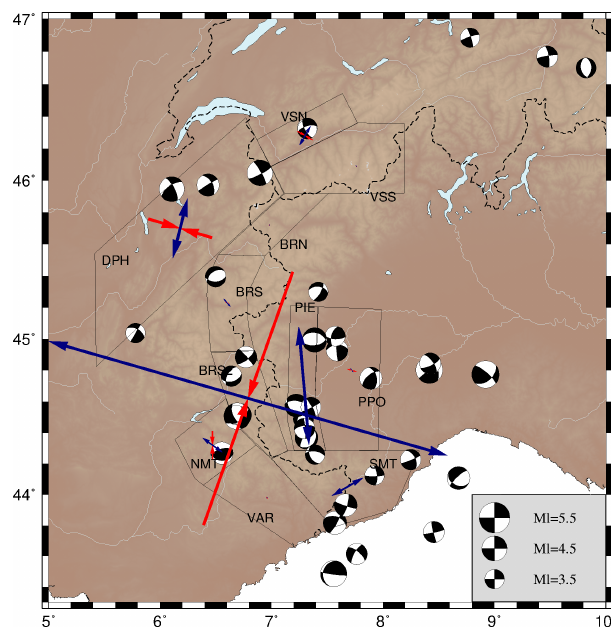
Figure 4. Seismic strain rates computed according to Kostrov’s (1974) method in each of the 11 subareas, based on 25 years of seismicity records from Potin (2016). Blue and red arrows respectively show the extensive and compressive components of the strain rate projected at the surface ( ε ∗ cos (δ) ), where ε is the given eigenvalue and δ is the dip (see values in Table 1). Black arrows represent the scale of the strain rate. Focal mechanisms with M l ≥ 3.5 are represented in the background since strain rates mostly depend on higher-moment tensors.